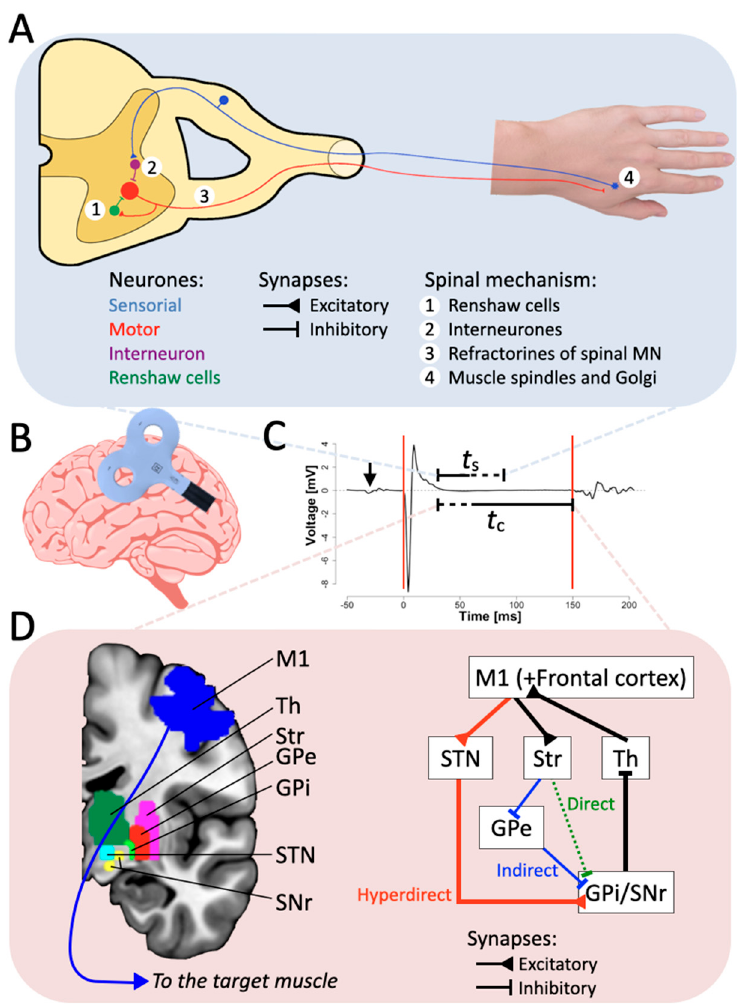
Figure 1. The inhibitory hyperdirect pathway contributes to the CSP duration. ( A ) Schematic representation of the spinal components of the CSP. Excitation of M1 through single TMS pulse reaches spinal interneuronal circuits, which in turn excite hand muscles. The four spinal mechanisms presented in the scheme contribute only to the first 50 ms of the CSP. ( B ) Schematic representation of the TMS coil stimulation in M1. ( C ) Example of an MEP. The red lines represent the usual limit defined for the CSP. “ t s ” and “ t c ” stand for the duration elicited by the spinal and the cortical part, respectively, and the arrow represents the TMS pulse artifact. ( D ) Simplified schematic diagram of the CBGTC loop, at least partially accounting for the later part of the CSP. Abbreviations: Str: striatum; STN: subthalamic nucleus; GPe: external segment of the globus pallidus; GPi: internal segment of the globus pallidus; SNr: substantia nigra pars reticulata; Th: thalamus.